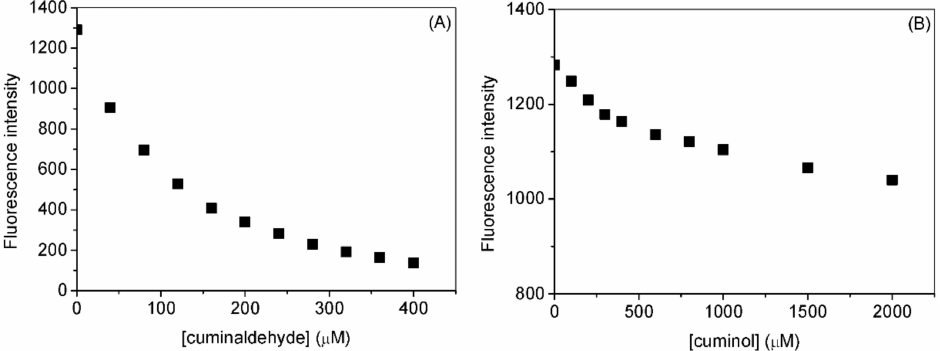
Figure 4. Effect of cuminaldehyde ( A ) and cuminol ( B ) on the fluorescence intensities of HSA at λ ex = 295 nm and 25 ◦ C. [HSA] = 3.0 µ